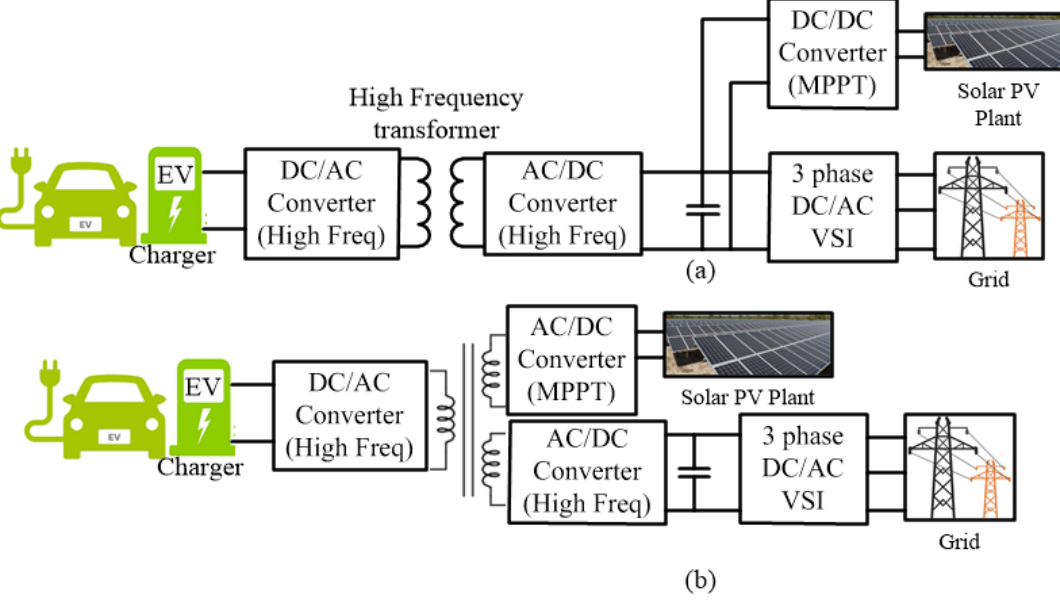
Figure 4. Block representation of multiport converters. ( a ) MPCA; ( b ) MPCB.